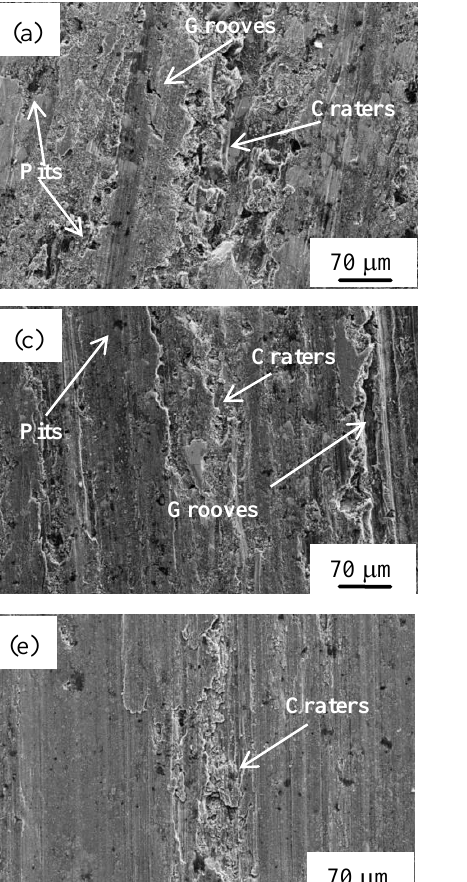
Figure 4. Relationships between the wear rates of (B 4 C+Ti)/Mg and (B 4 C+Ti)/AZ91D composites and holding time.